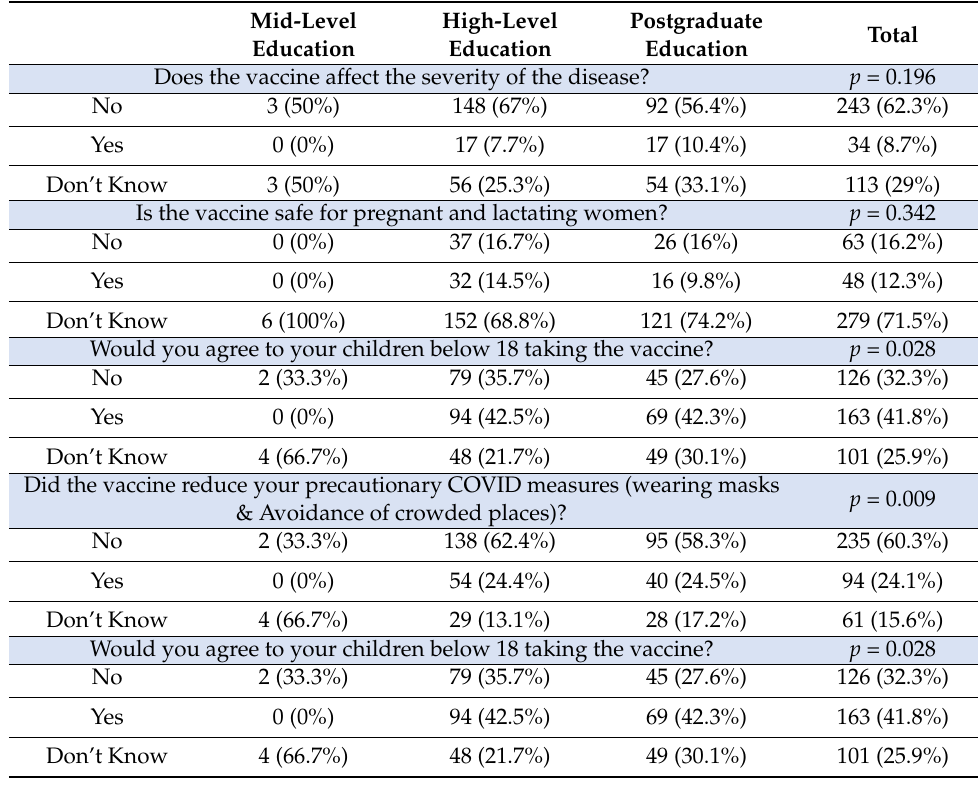
Table 5. Vaccination knowledge, expectations, and attitude